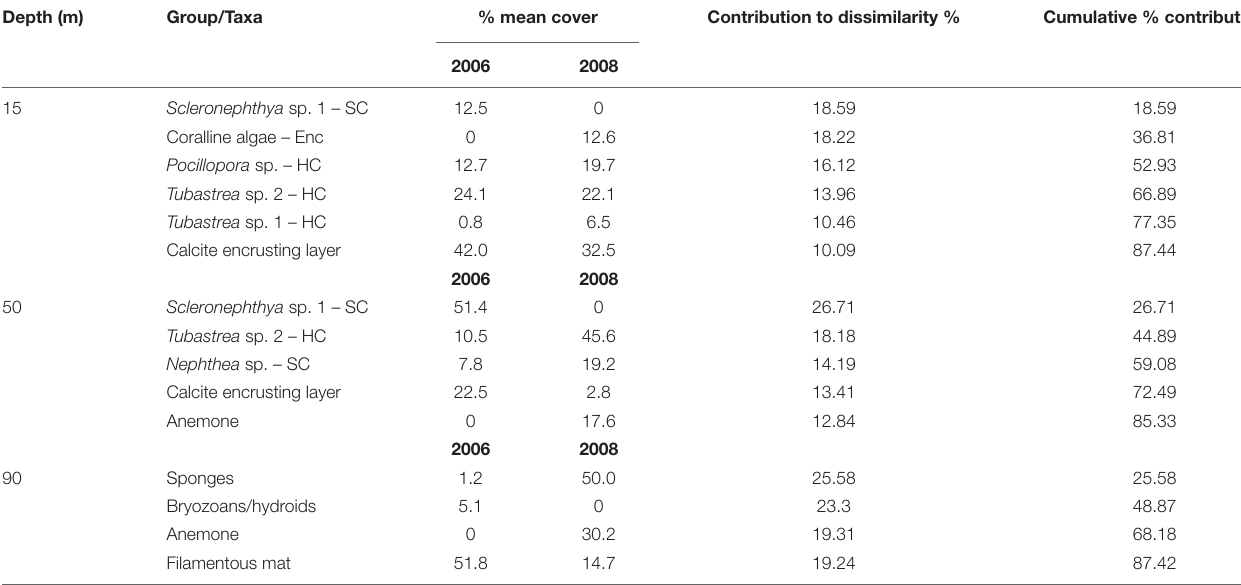
TABLE 3 | Dissimilarity and percent mean cover of attached invertebrates between depths in 2006 and